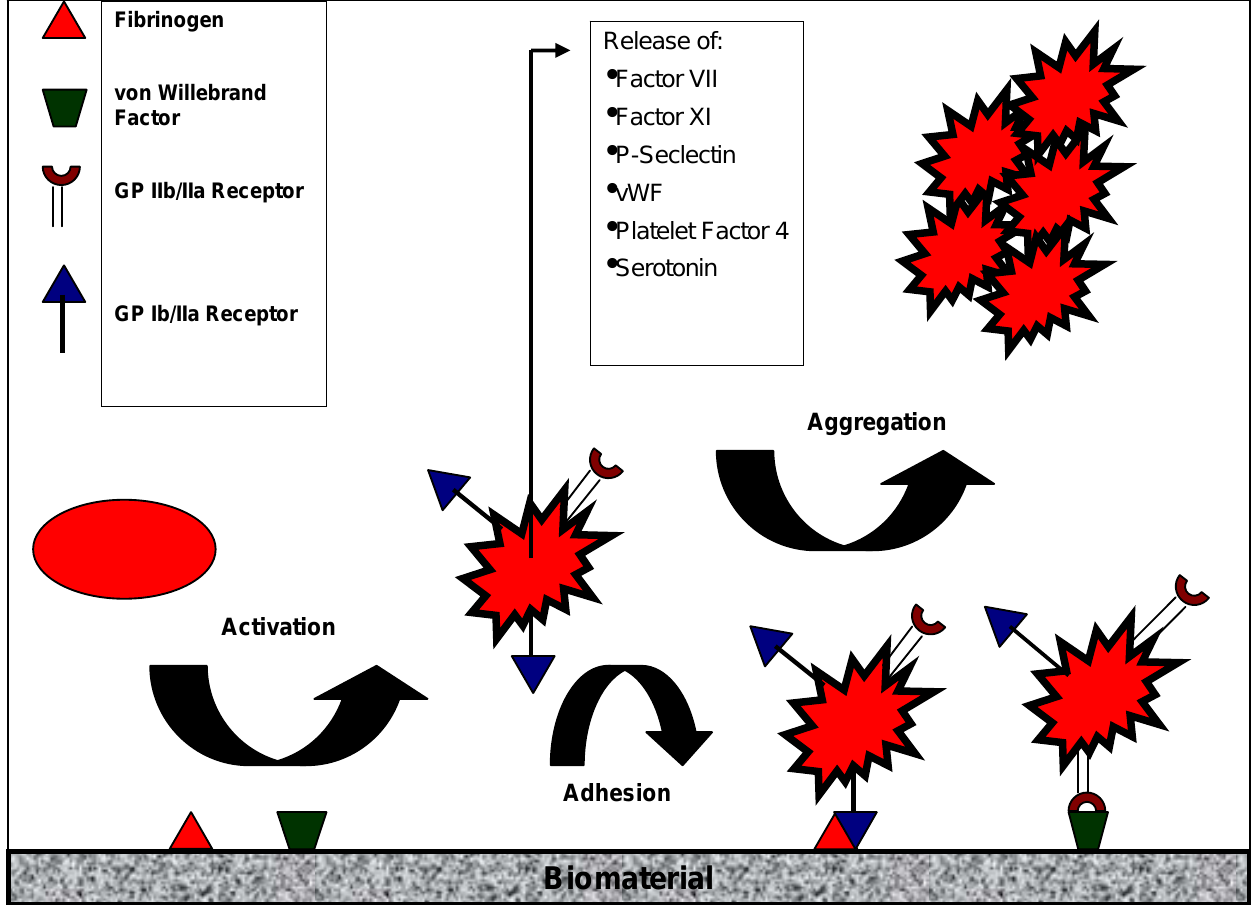
Figure 2. Activation of platelets by artificial surfaces. Contact of platelets with artififcial surfaces leads to platelet activation in terms of ligand expression (GP IIb/IIIa). Activated platelets either adhere to the sufaces ( via proteins like fibrinogen) or aggregate (details see